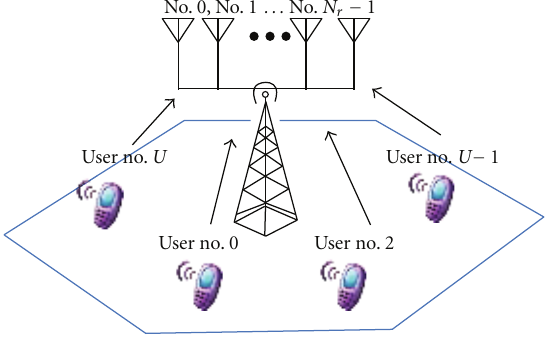
Figure 1: Uplink transmission in a single cell.